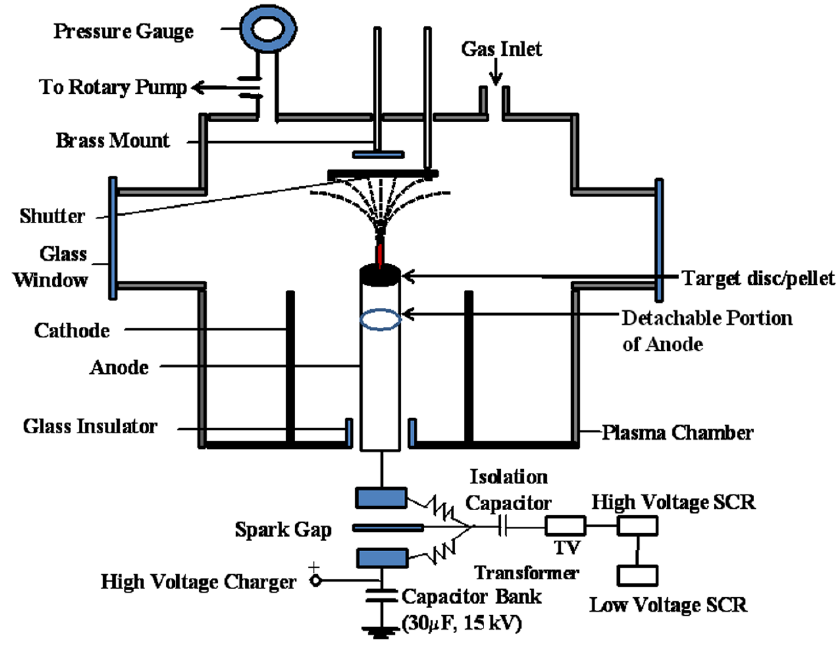
Figure 10. Schematic of modified dense plasma focus device.